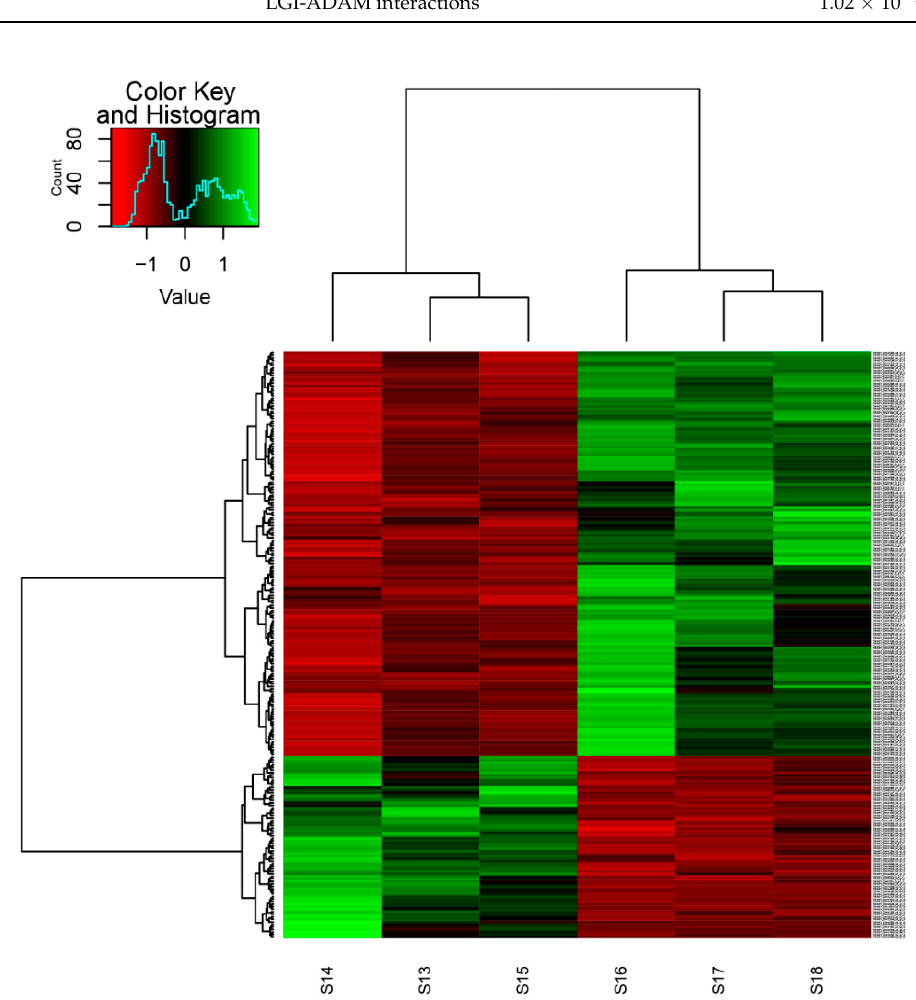
Figure 2. Heat-map illustrating gene expression profiles of transcripts. The x -axis represents the six RNAseq libraries from the two groups (S13, S14, S15 normal pigmented, S16, S17, S18 ambicolorated), and the y -axis represents the transcripts clustered according to their expression pattern. Gene expression is color-coded; red represents the down-regulated transcripts and green the upregulated ones. The 157 differentially expressed transcripts, mapped to their ortholog from zebrafish, were ranked in terms of gene ontology categories. Gene ontology enrichment analysis was performed in DAVID v6.8 determined by Fisher Exact test ( p < 0.05) [36]. The differentially expressed (d.e.) transcripts grouped as biological process, cellular component, and molecular function are presented in Table 2 and Figure 3 .